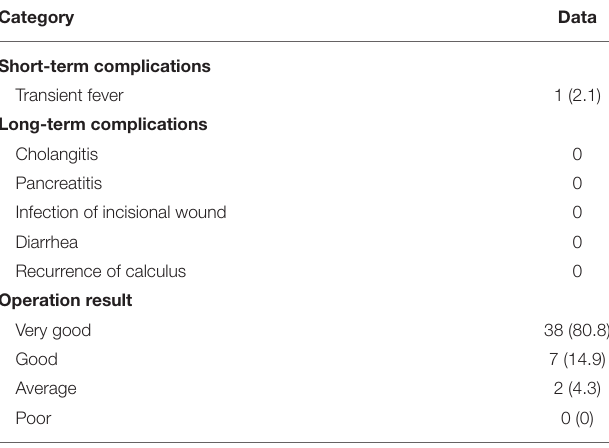
TABLE 2 | Follow-up information of patients ( n = 47). Category